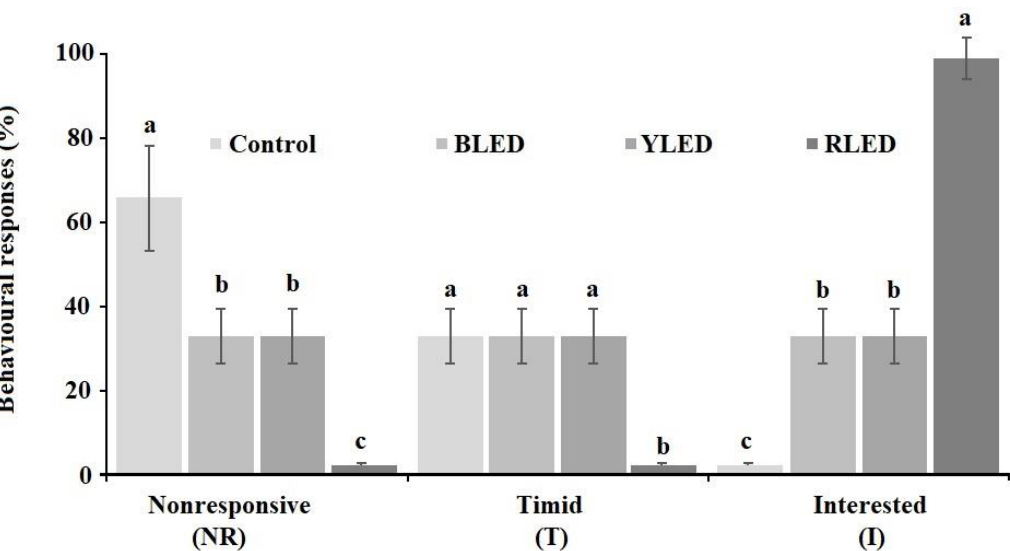
Figure 6. Home cage avoidance results (%). a, b, c-different lowercase superscripts were significantly different at p < 0.05.